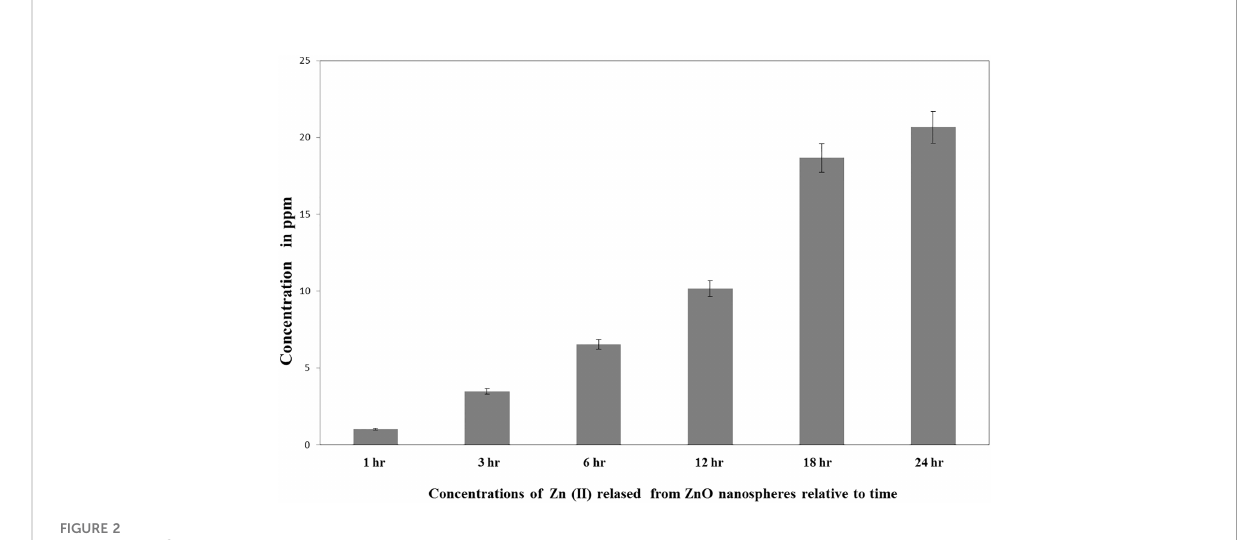
FIGURE 2 Released Zn +2 ions from ZnO nanospheres by ICP-AES.